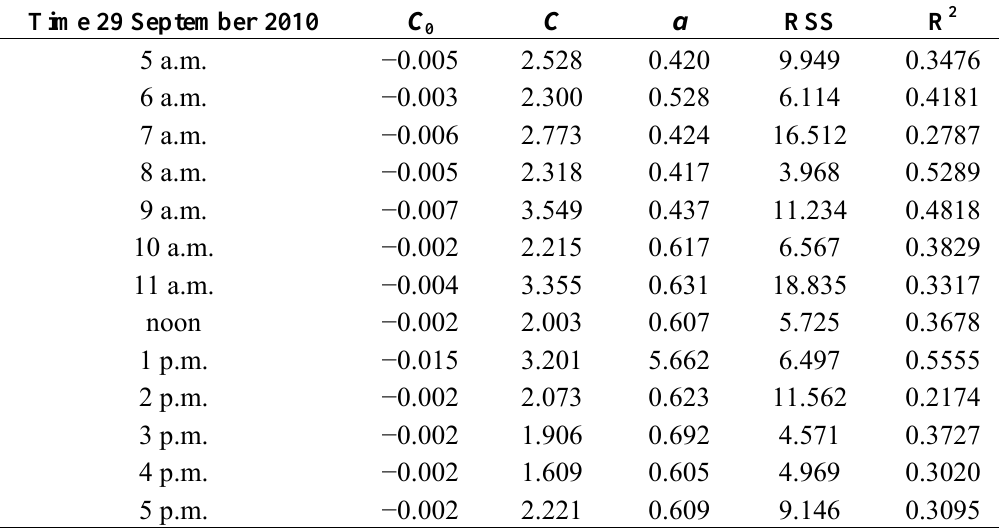
Table 4. Fitted parameters of exponential